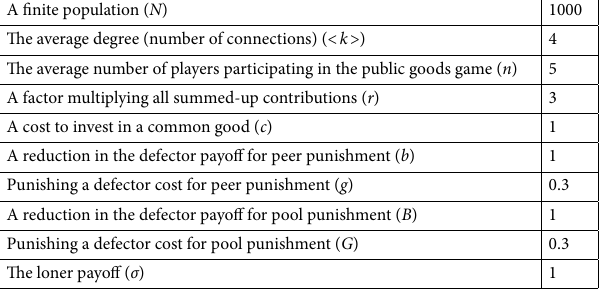
Table 1. Parameter settings required for